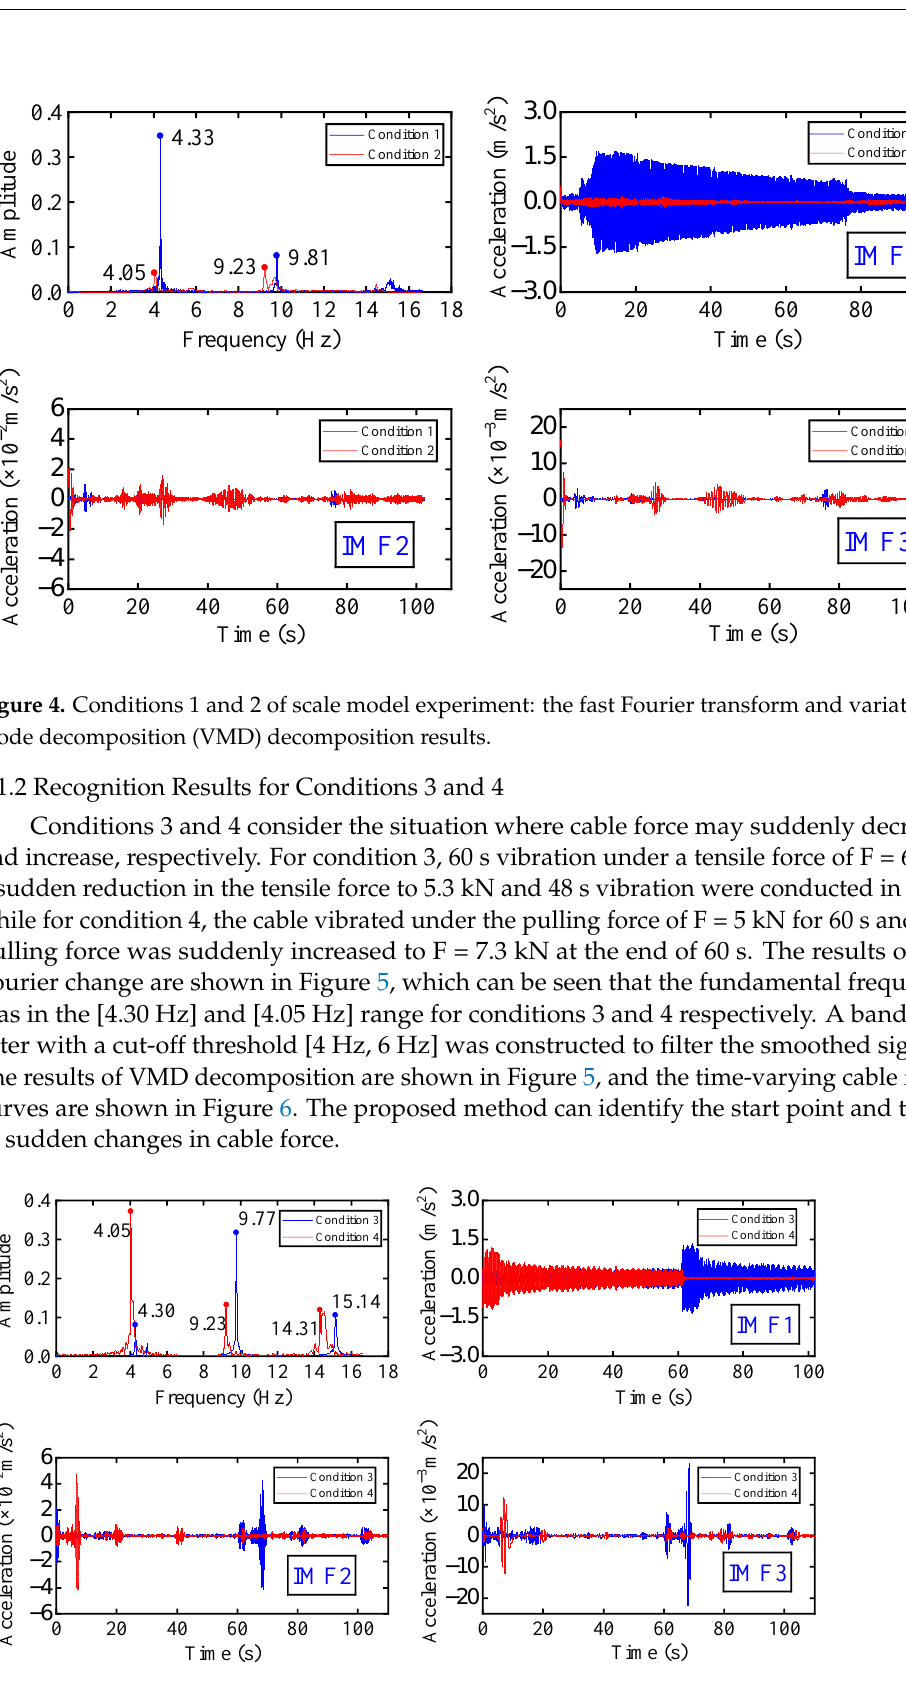
Figure 5. Conditions 3 and 4 of scale model experiment: the fast Fourier transform and VMD decomposition